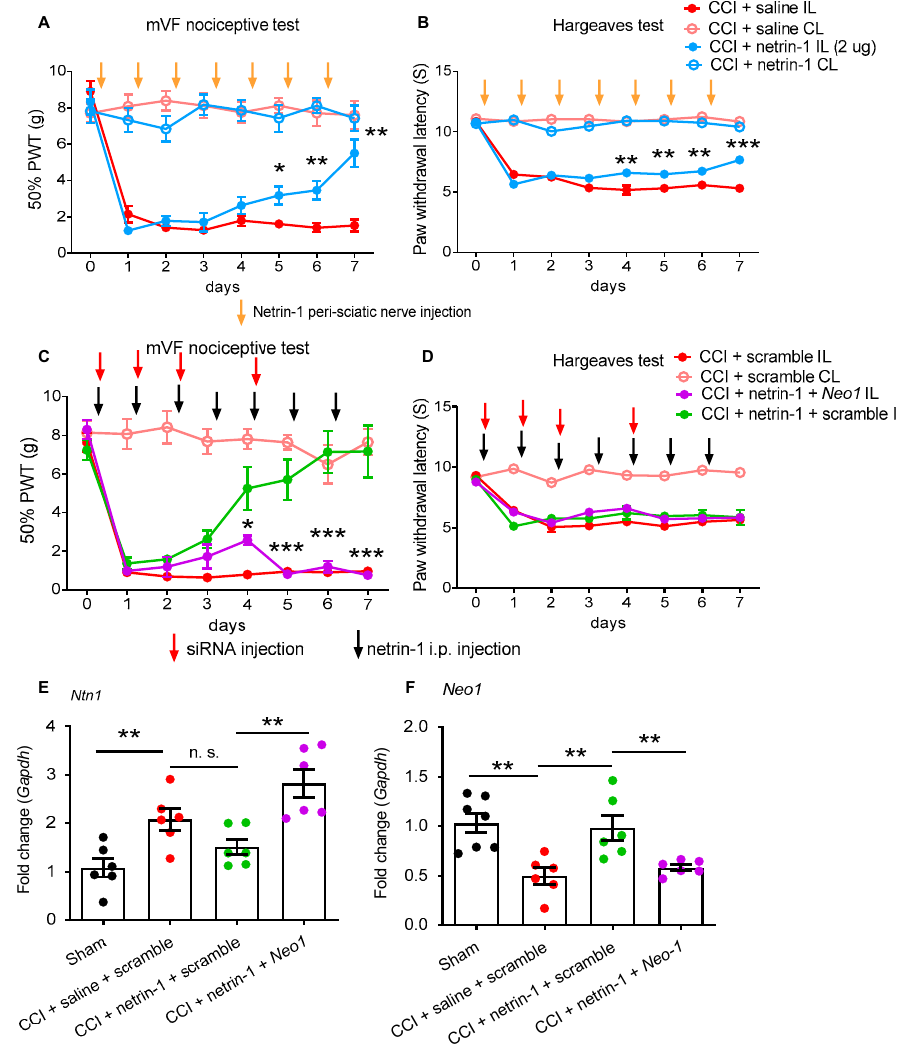
Figure 3. Netrin-1-induced antinociception requires Neo1 in the sciatic nerve. Wistar rats underwent CCI surgery. ( A ) The time-course analyses of daily peri-sciatic injection of 2 μ g netrin-1 was analyzed for the sensitivity to mechanical and ( B ) thermal stimulation (two-way ANOVA with Bonferroni’s post hoc test comparing netrin-1 vs. saline). The orange arrows indicate peri-sciatic injection time points. ( C , D ) Rats were treated 4× with perisciatic Neo1 -siRNA or scramble siRNA (2 μ g; red arrows) and daily systemic netrin-1 injections (10 μ g/rat; black arrows) and tested for mechanical and thermal hypersensitivity (two-way ANOVA with Bonferroni’s post hoc test comparing Neo1- siRNA vs. scramble) as well as Ntn1 and Neo1 ( E , F ) in the sciatic nerve (Mann–Whitney U test). All mean ± SEM, * p < 0.05, ** p < 0.01, *** p < 0.001, n.s.: not significant n = 6.